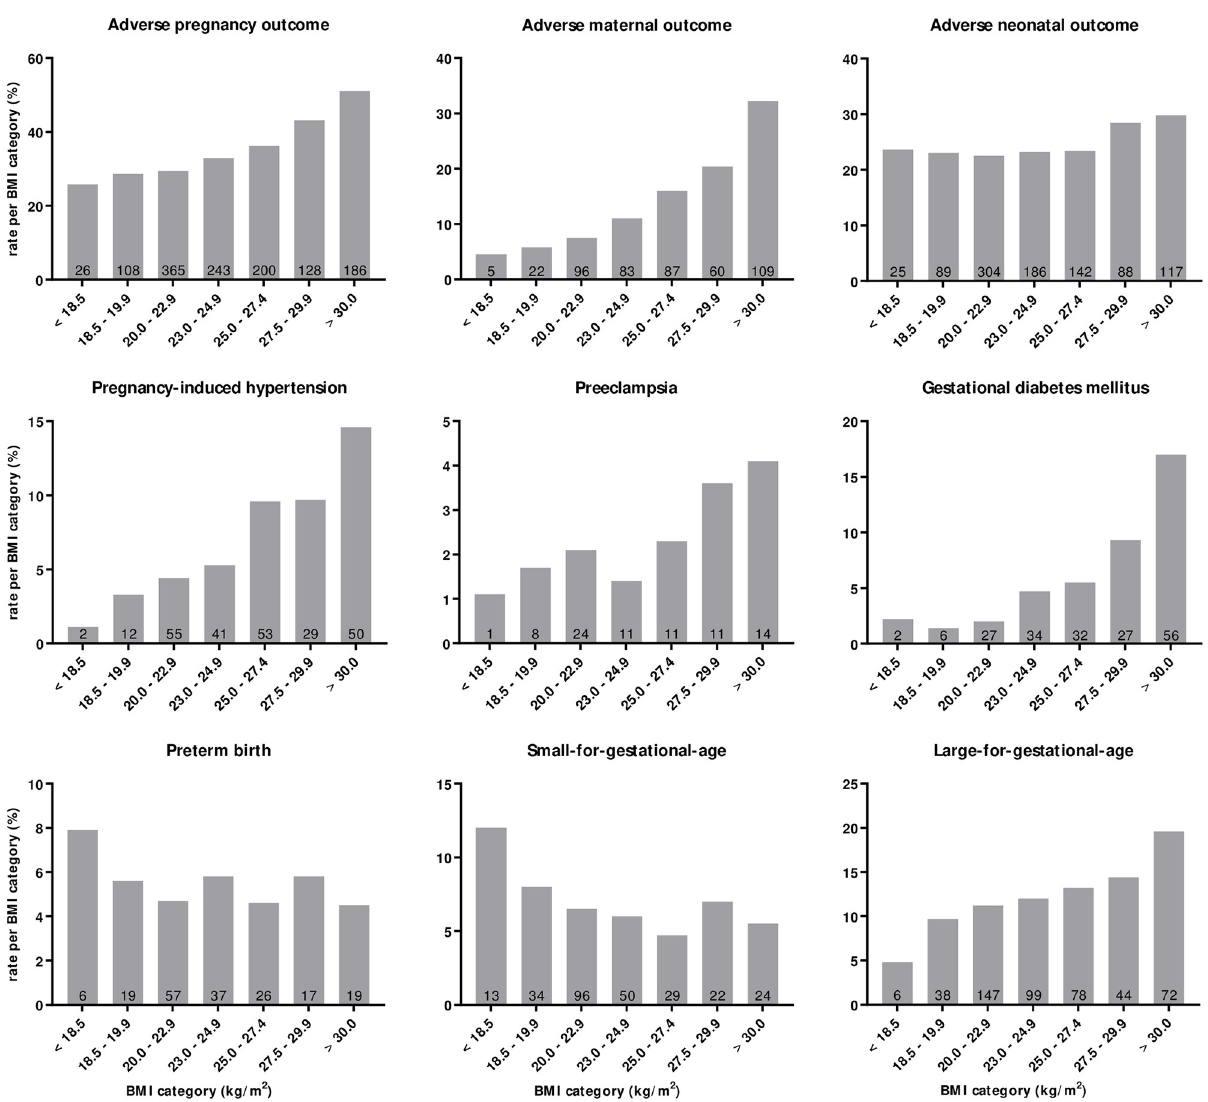
Fig 2. The rate of pregnancy outcomes and number of events per maternal prepregnancy body mass index (BMI) category. The height of the grey bars indicate the rate of pregnancy outcomes per BMI category (the number of events per BMI category divided by the total number of subjects within that BMI category; expressed as a percentage). The number in the grey bars represents the number of events per maternal prepregnancy body mass index (BMI) category. Adverse maternal outcome (composite): pregnancy-induced hypertension, preeclampsia, gestational diabetes mellitus, thromboembolic event, eclampsia, maternal death. Adverse neonatal outcome (composite): preterm birth (gestational age < 37 weeks), small-for- gestational-age ( < 10 th birthweight percentile), large-for-gestational-age ( > 90 th birthweight percentile), neonatal intensive care admission, Apgar-score < 7 after 5 minutes, pH < 7.0 in arterial cord blood, congenital anomalies, perinatal death. Adverse pregnancy outcome (composite): adverse maternal and/or neonatal